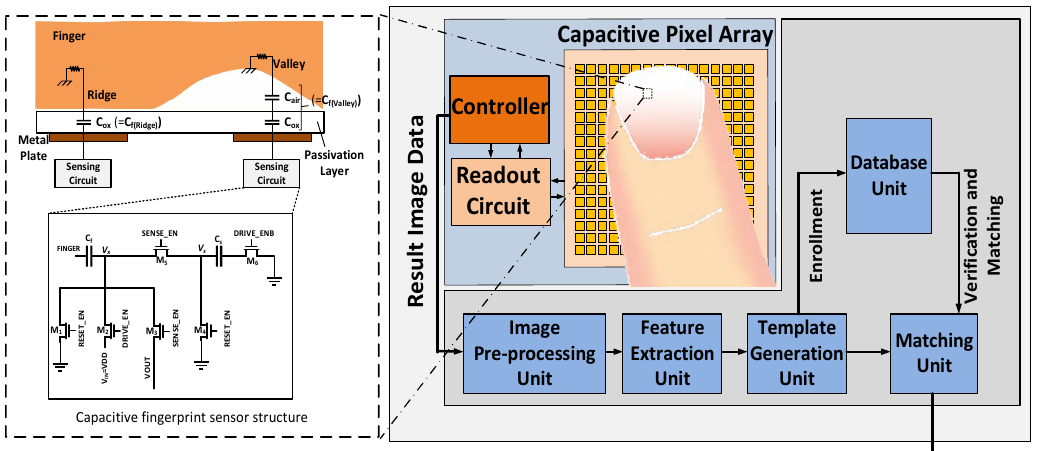
Figure 1. A general scheme of a fingerprint biometric system.